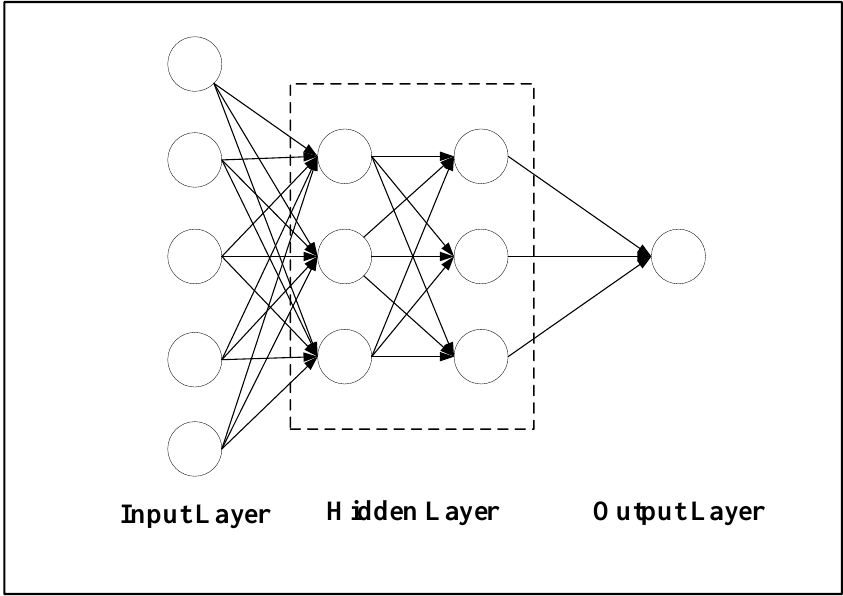
Figure 2. The structure of neural network.